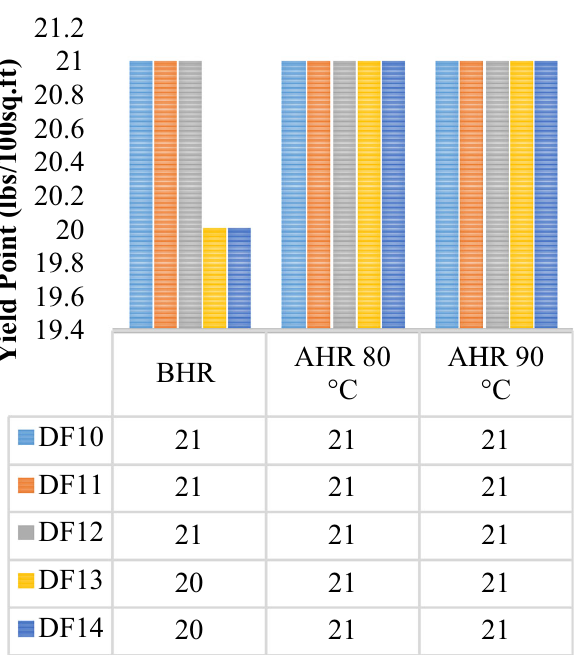
Fig. 12 Variation of YP after hot